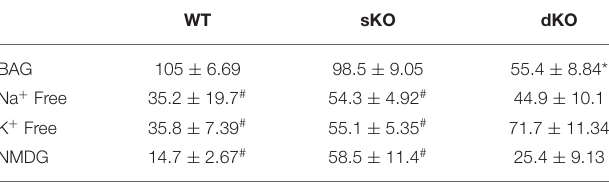
TABLE 3 | Baseline [Ca 2 + ] intra in